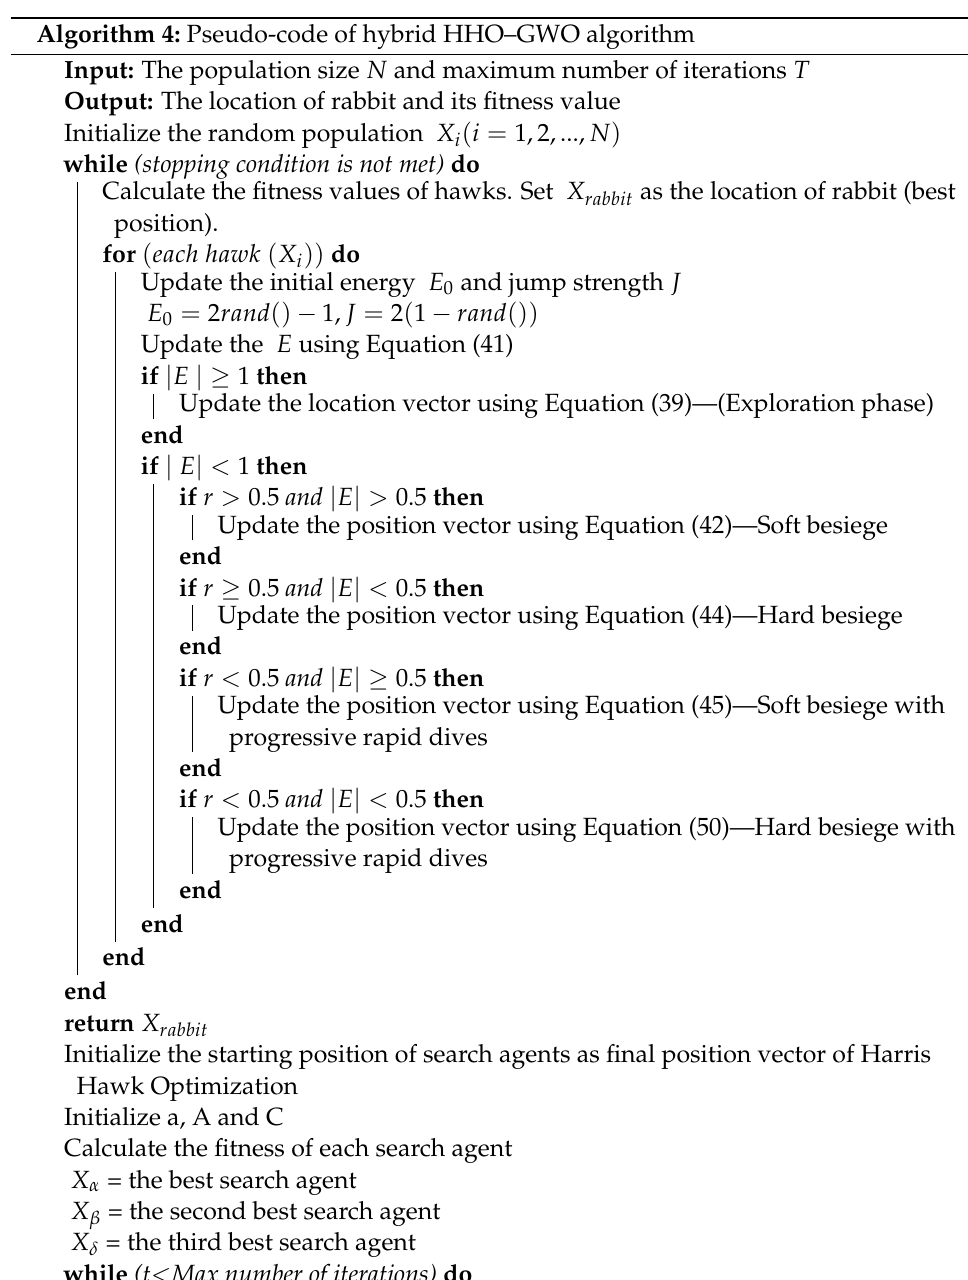
Algorithm 4: Pseudo-code of hybrid HHO–GWO